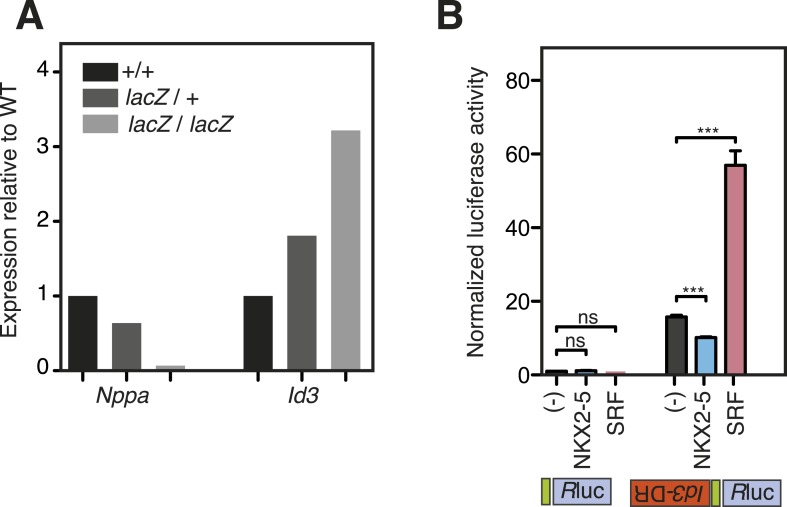
WT and mutant NKX2-5 targets identified by DamID in HL-1 cells.(A) Nppa and Id3 expression in Nkx2-5LacZ/+ heterozygous and Nkx2-5LacZ/LacZ null homozygous embryos relative to wild type (+/+) at E8.5. Expression was normalised to HPRT. (B) Normalised Renilla Luciferase (Rluc) activity in HEK 293 cells transfected with NKX2-5 and SRF. The 1270-bp Id3 DR region was cloned in sense or antisense orientations upstream of Rluc driven by a minimal TATA promoter. p-values were calculated relative to controls using an unpaired t-test (*** p < 0.001; ns = not significant).